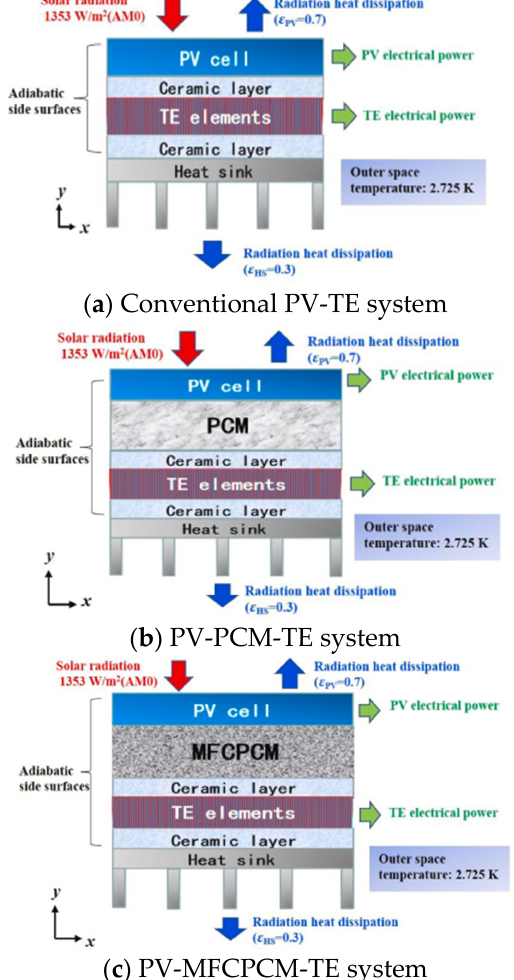
Figure 2. Schematic of the systems investigated [15]. Reproduced with permission from Elsevier.